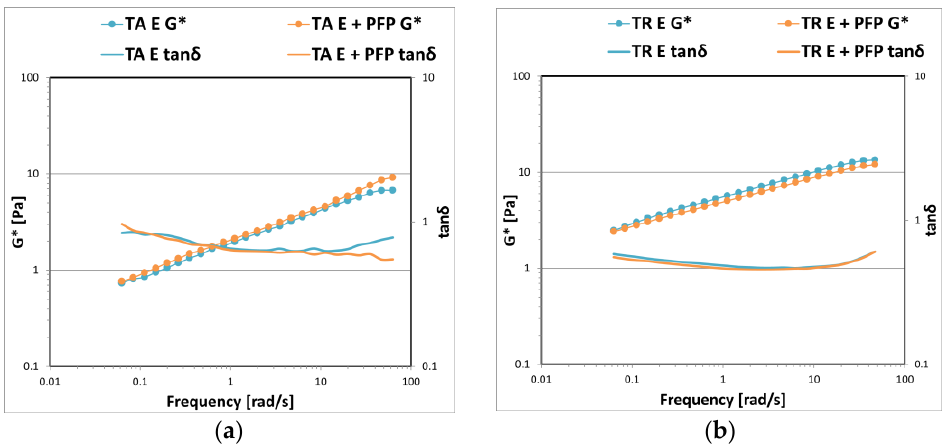
Figure 11. The trend of the complex G* modulus and the damping factor tan δ in the function of the oscillation frequency for the gel–creams before and after adding 3% w / w of PFP: ( a ) TA E prepared with T at 0.2% w / w , A at 0.2% w / w and E at 0.3% w / w and ( b ) TR E prepared with T at 0.2% w / w , R at 0.2% w / w and E at 0.3% w / w .